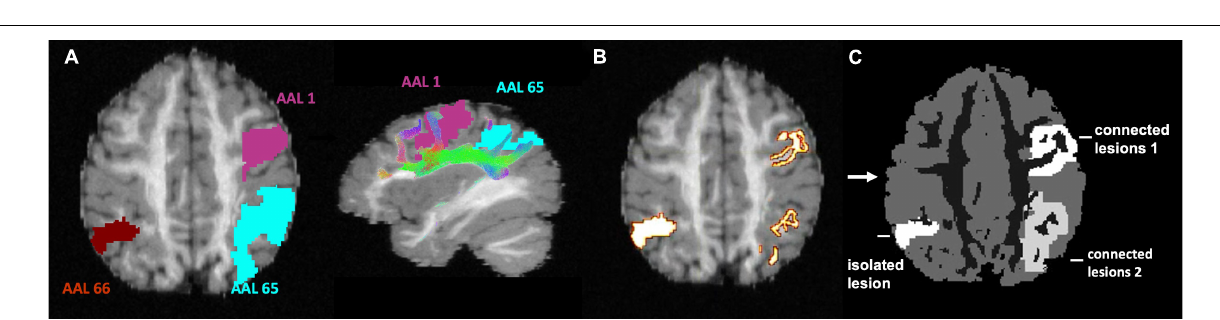
FIGURE 4 | Overview of data simulation, processing and CONN-NLM filtering framework. (A) Top: simulation of DWIs based on ground-truth fibre tracks; bottom: simulation of raw PET sinograms, which are then reconstructed to generate PET images (B) the simulated DWIs are processed to generate tractogram and structural connectivity matrices (C) the proposed post-reconstruction filter is applied to improve the PET image quality.